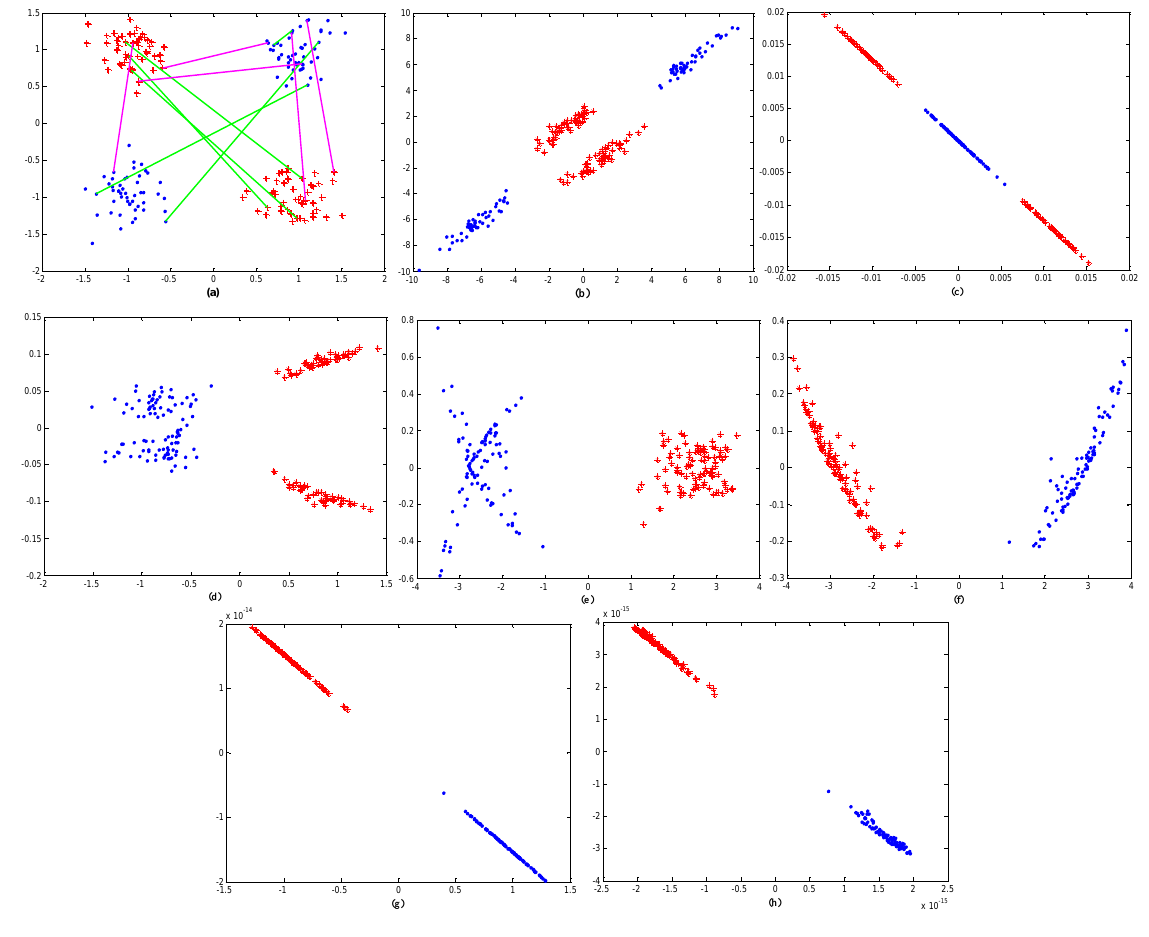
Figure 2. Comparison of different metric learning methods on XOR dataset. (a) Original dataset with two classes, and dataset after applying (b) RCA, (c) Xing’s, (d) kernel-  , (e) unweighted-S, (f) unweighted-SD, (g) augmented-S, and (h) augmented- SD.